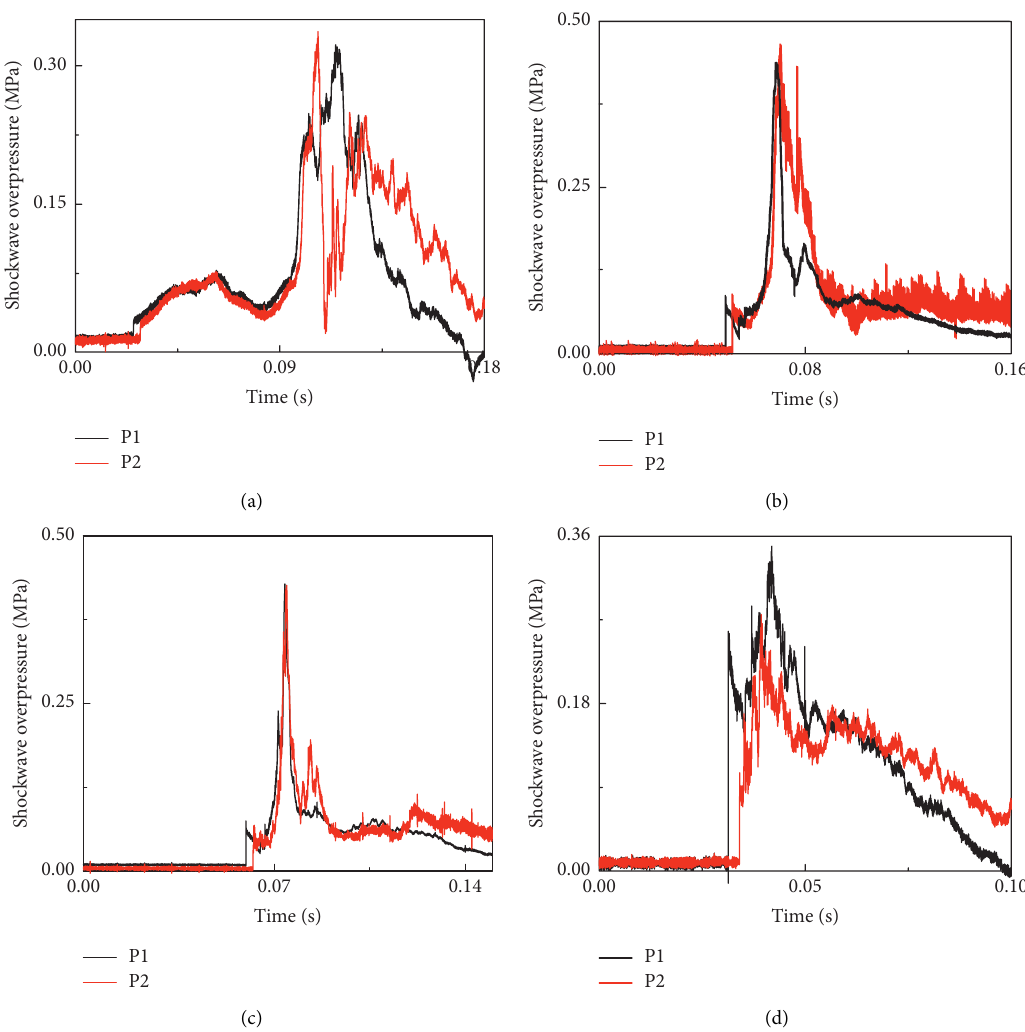
Figure 3: Explosion overpressure-time curve at the chamber inlet and outlet. (a) Pipeline section without a chamber; (b) chamber of L0.5m × W0.3m × H0.2m; (c) chamber of L0.5m × W0.5 m × H 0.2m; (d) chamber of L0.5m × W0.8m ×